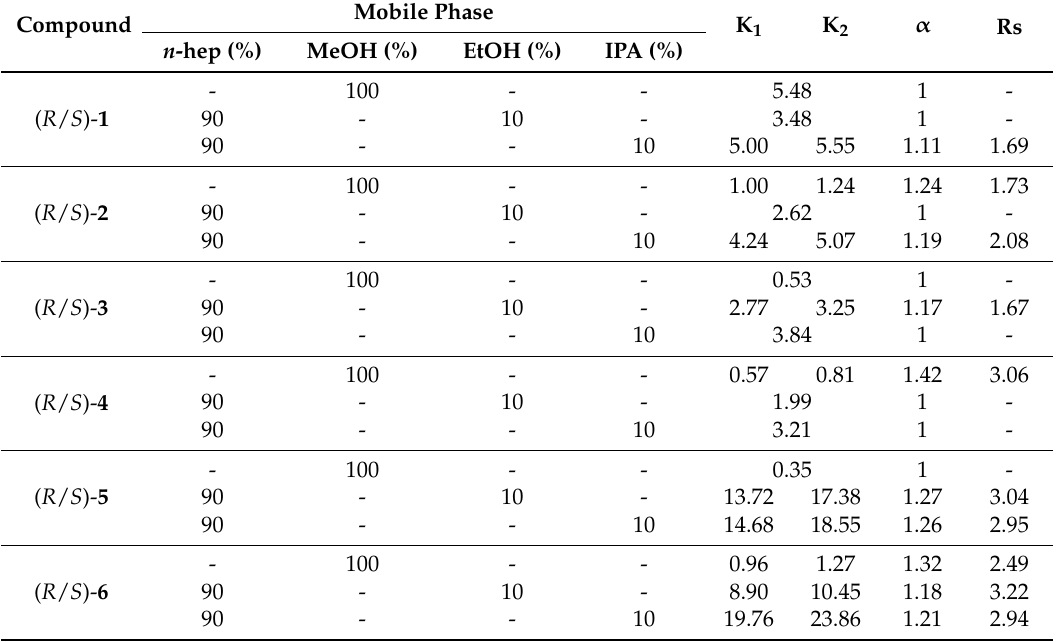
Table 4. Analytical screening on Chiralpak IA with different mobile phases containing 0.1% DEA. Mobile Phase Compound